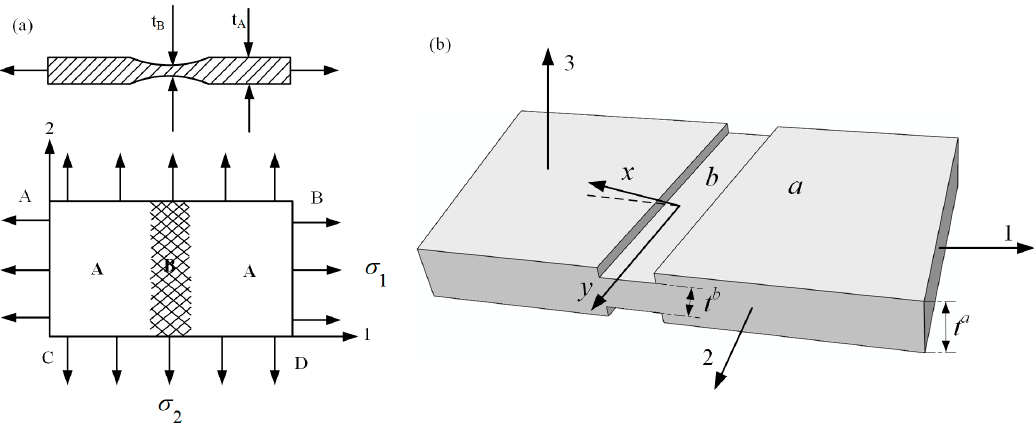
Figure 2. M–K model: ( a ) classical model [30]; ( b ) modified model [34].